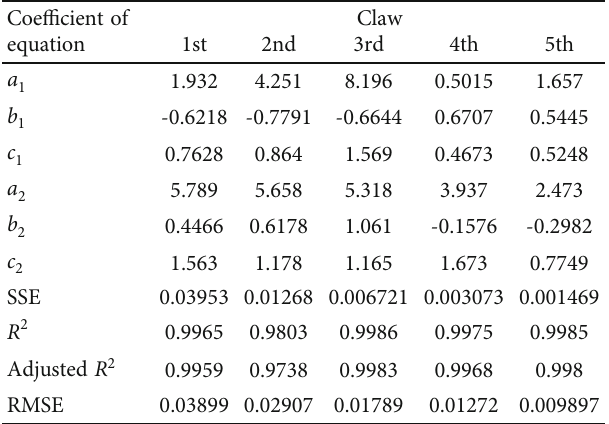
Table 1: Coe ffi cients of fi tting equations of the fi ve claw tips.